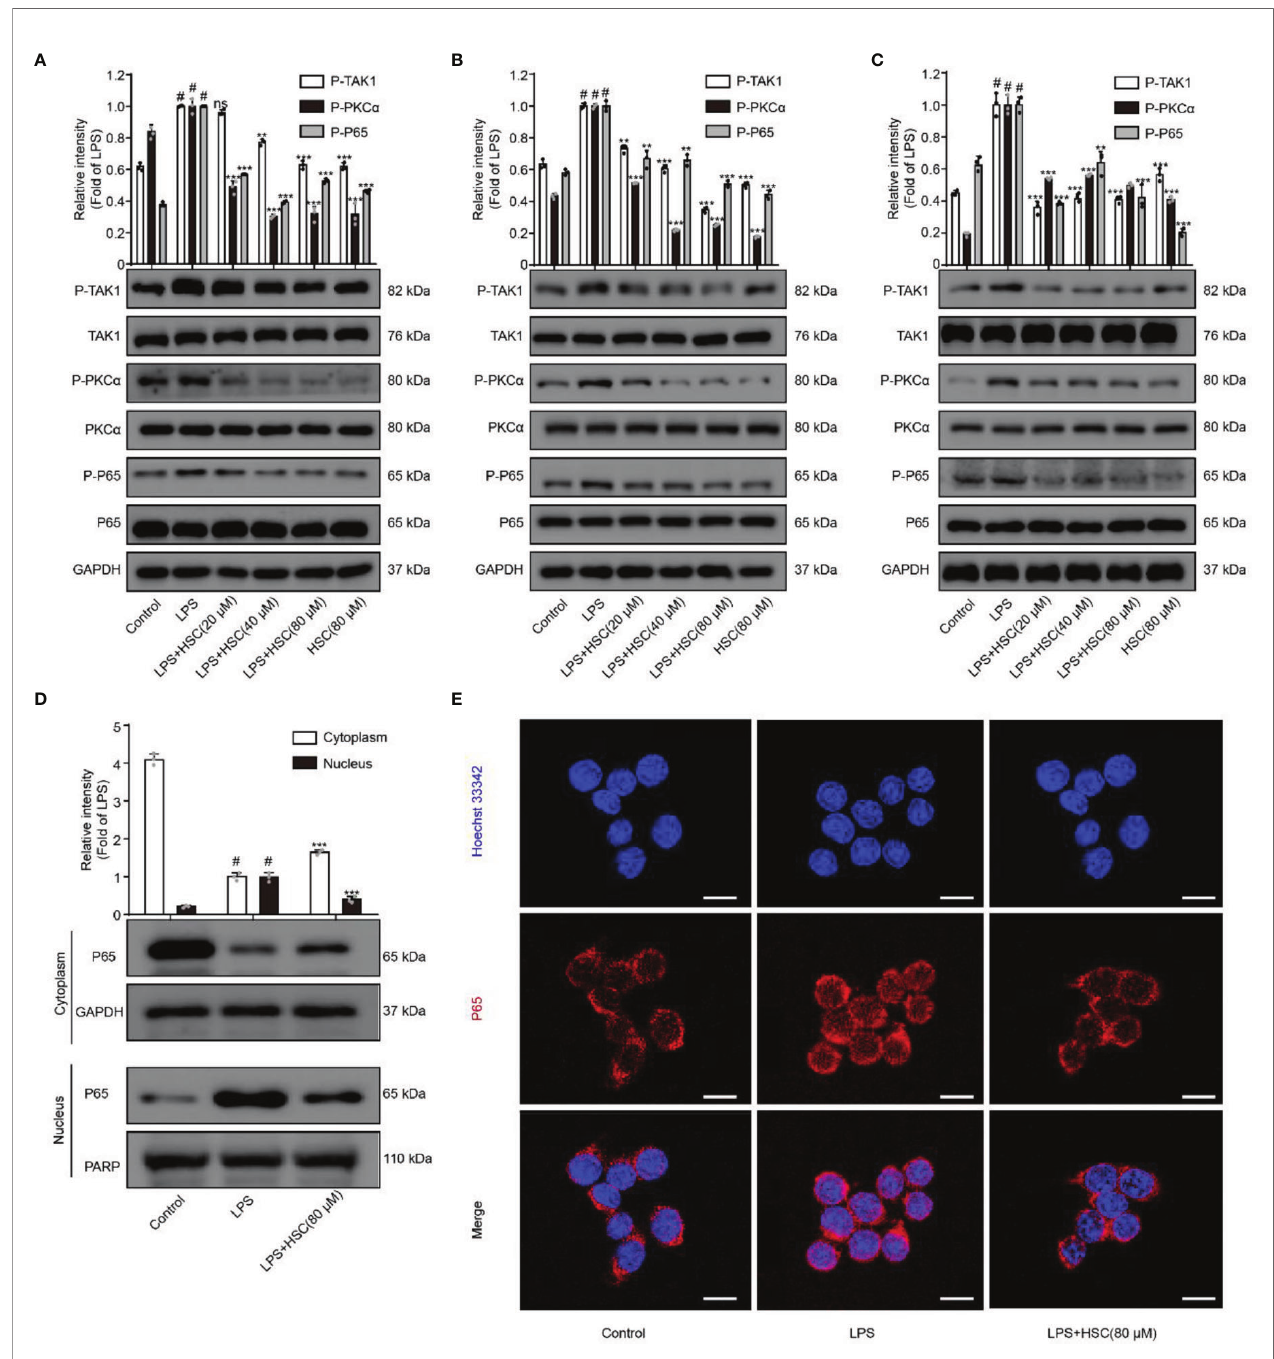
FIGURE 2 | Effect of HSC on NF- k B pathway. RAW264.7, J774A.1, THP-1 cells were treated with HSC for 4 h then LPS (1 m g/mL) was added for 2 h. The protein expression of TAK1/PKC/p65 in RAW264.7 cell (A) J774A.1 cell (B) and THP-1 cell (C) by western blotting; (D, E) The localization of p65 in the cytoplasm and nucleus of RAW264.7 cells was detected by western blotting (D) and immuno fl uorescence (E) (Scale bar = 20 m m).; # P < 0.001 compared to control alone group; ** P < 0.01, and *** P < 0.001, compared to LPS alone group, ns, no signi fi cance